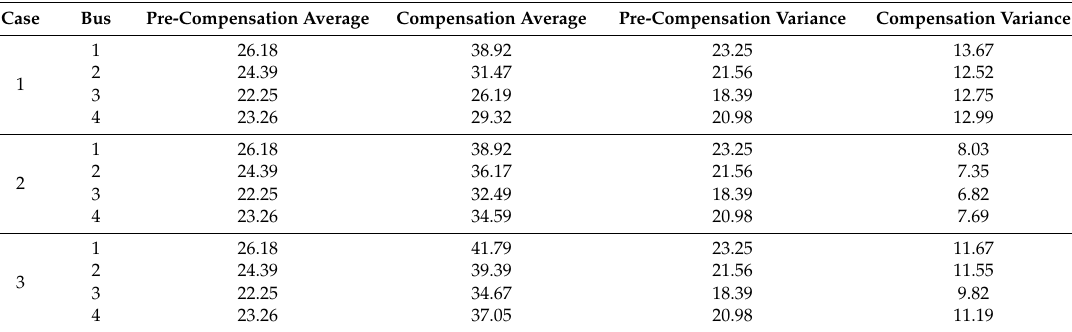
Table 2. Comparison of three cases (10 4